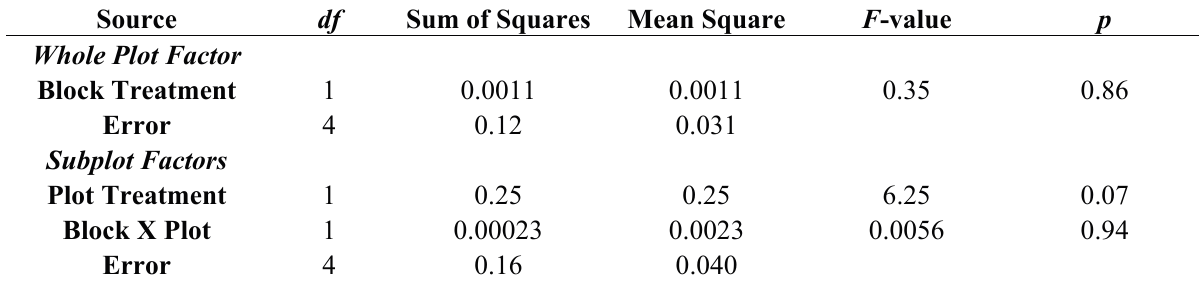
Table 2. Split-plot analysis of variance for the Three-dimensional Vegetation Patchiness Index (3PI). Block Treatment is Thinning and Burning/untreated, Plot Treatment is Grazed/ungrazed. Note that the mean of two 3PI values were used in the ANOVA, computed using two separate scans within each